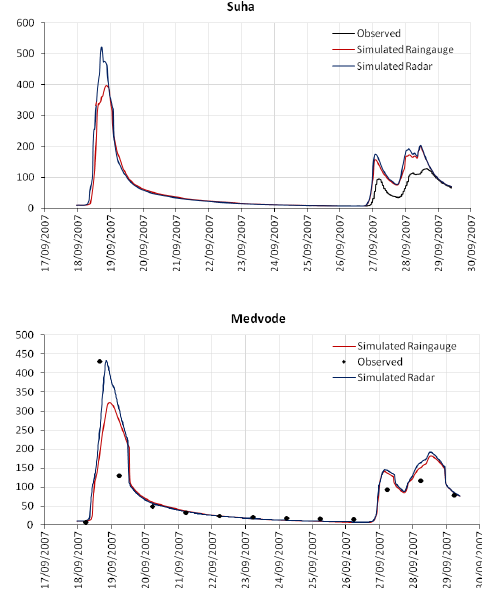
Fig. 6b. Model results for the flash flood period of 18 September Figure 6b: Model results for the flash flood period of September 18 th 2007 using interpolated 4 2007 using interpolated raingauge precipitation. Medvode observed raingauge precipitation. Medvode observed hydrograph is plotted with dots due to the daily 5 hydrograph is plotted with dots due to the daily time time resolution. 6